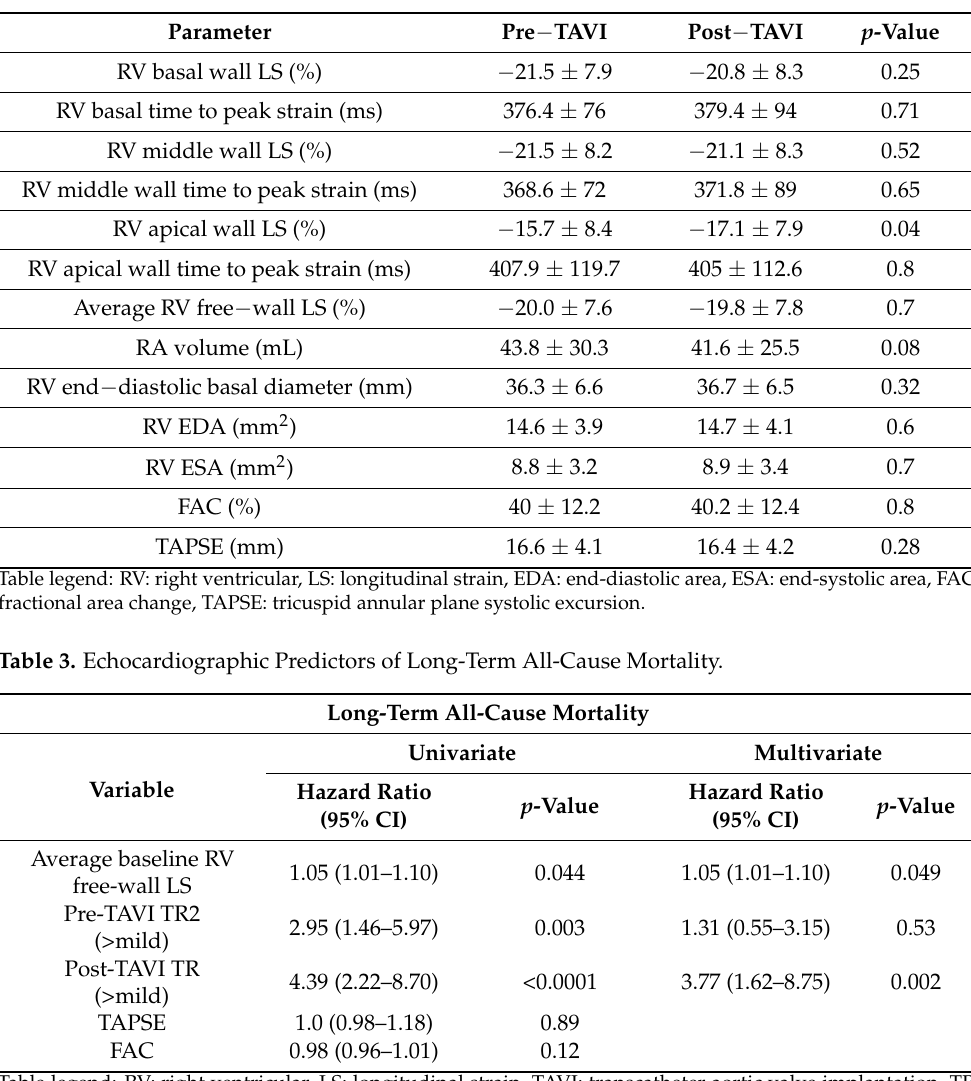
Table 2. Comparison of Pre- and Post- TAVI echocardiographic parameters.